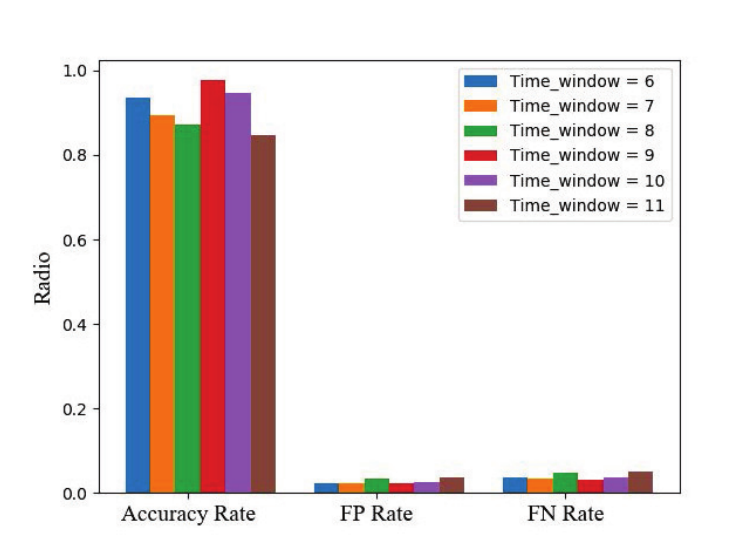
Figure 4. Detection results comparison of different time windows.